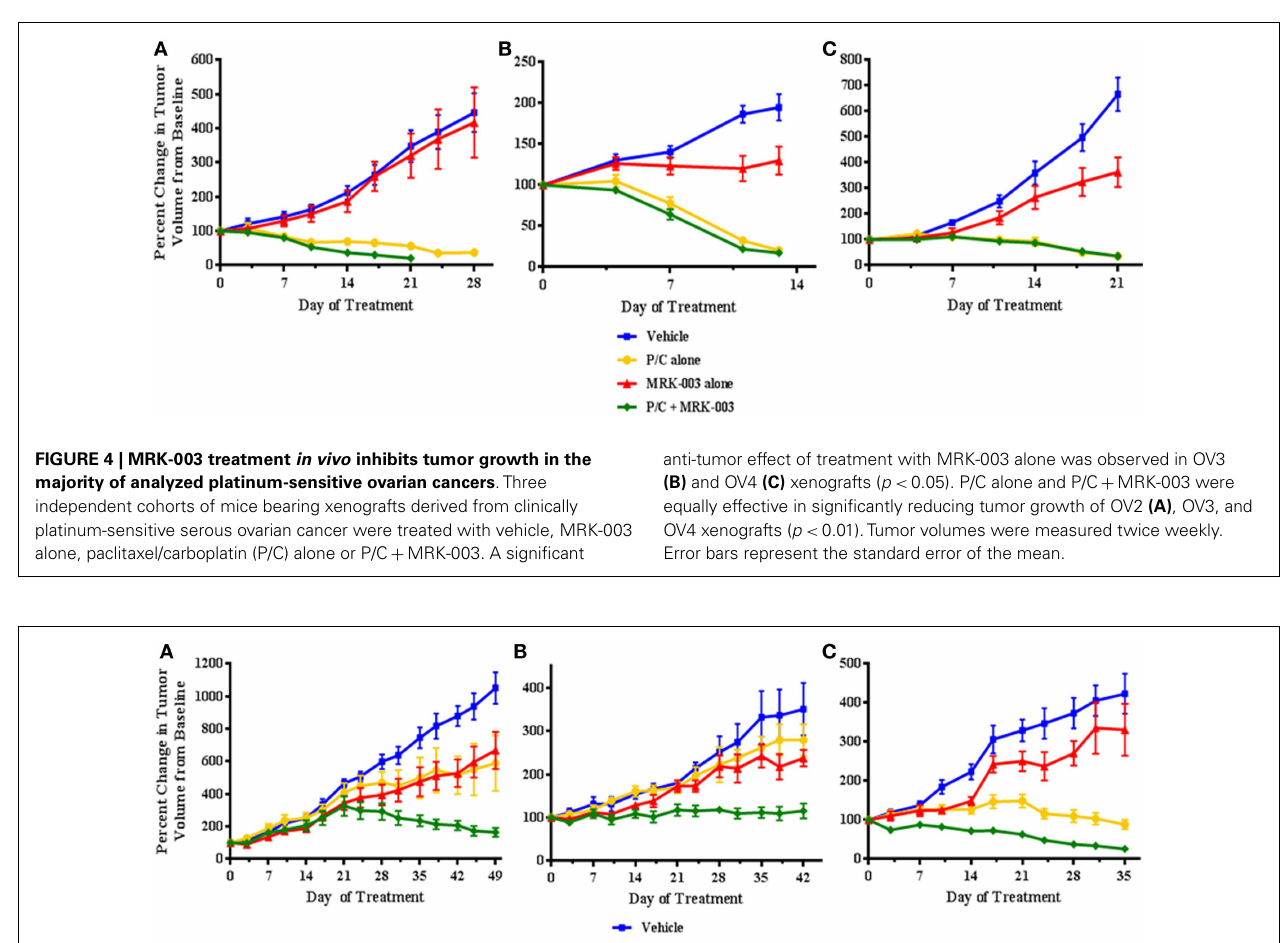
Significantly heightened inhibition of tumor growth was observed upon combination treatment with paclitaxel + MRK-003, compared with treatment with either drug alone ( p < 0.03).Tumors were measured twice weekly. Error bars represent the standard error of the mean. OV5 (A) ; OV6 (B) ; and OV7 (C)